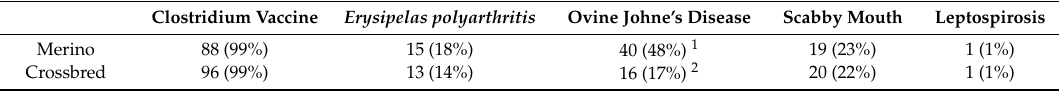
Table 4. Vaccination type administered to lambs by breed at marking and / or weaning from 129 NSW sheep producers who identified to vaccinate lambs in a 2019